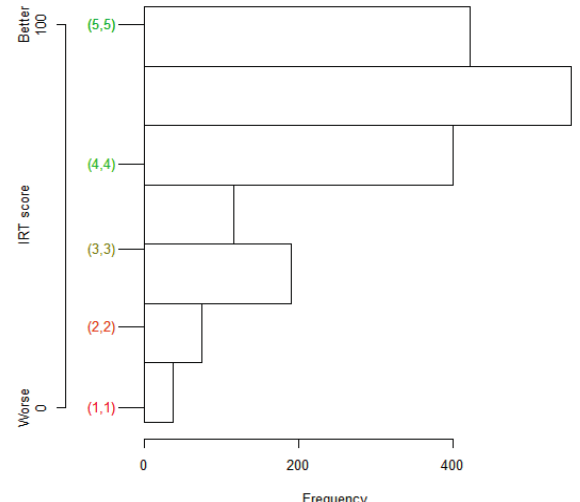
Figure 2. Item-person map for the Sense of Security scale in type 2 diabetes. IRT scores